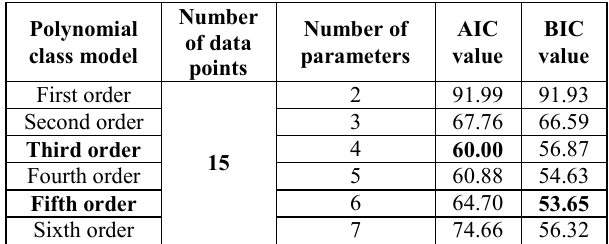
Table 1. Result with small sample (15